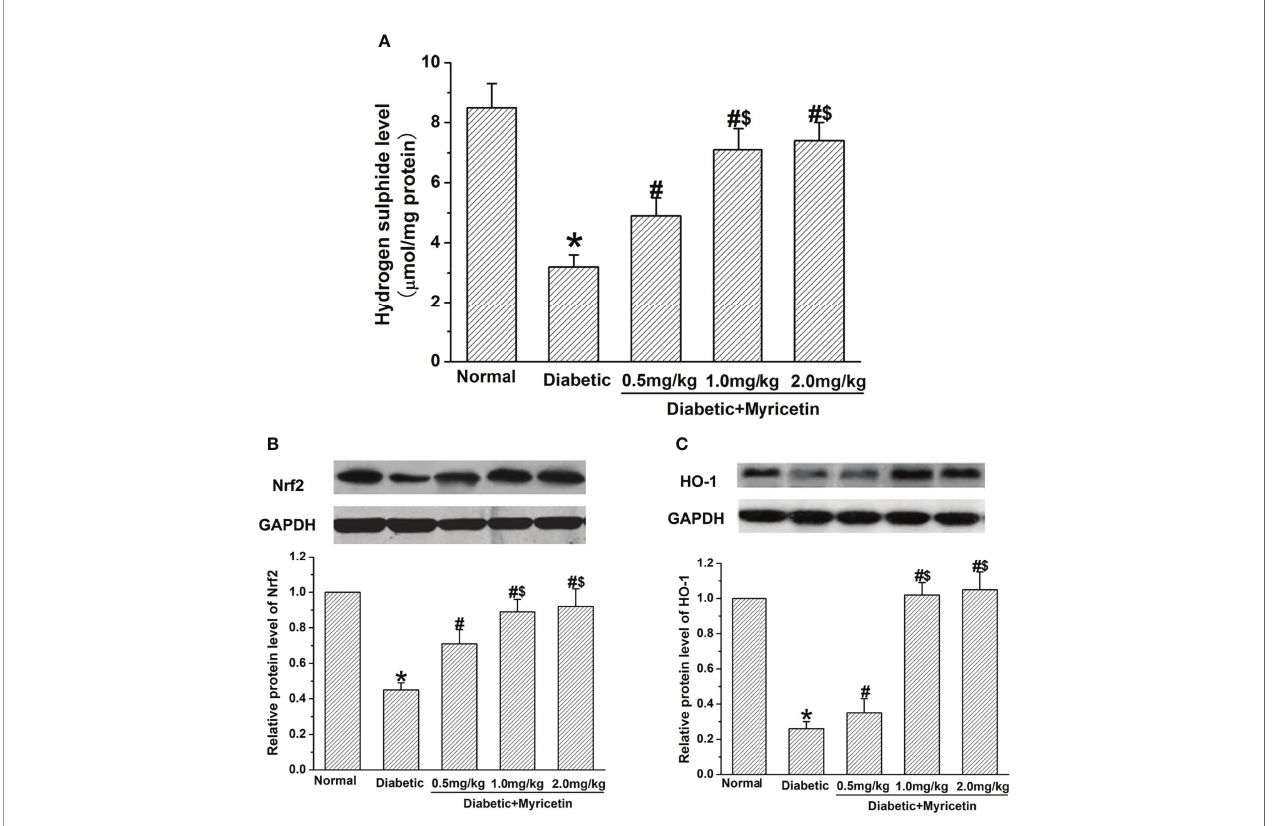
FIGURE 5 | The effect of myricetin on H 2 S, Nrf2, and HO-1 under diabetic conditions ( n = 10 for each group). STZ signi fi cantly decreased the levels of H 2 S (A) , Nrf2 (B) , and HO-1 (C) . Administration of myricetin signi fi cantly reduced the levels of H 2 S (A) , Nrf2 (B) , and HO-1 (C) under diabetic conditions. * p < 0.05 for the comparison to the normal group, # p < 0.05 for the comparison to the saline-treated diabetic rats. $ p < 0.05 for the comparison to the diabetic rats treated with myricetin at 0.5